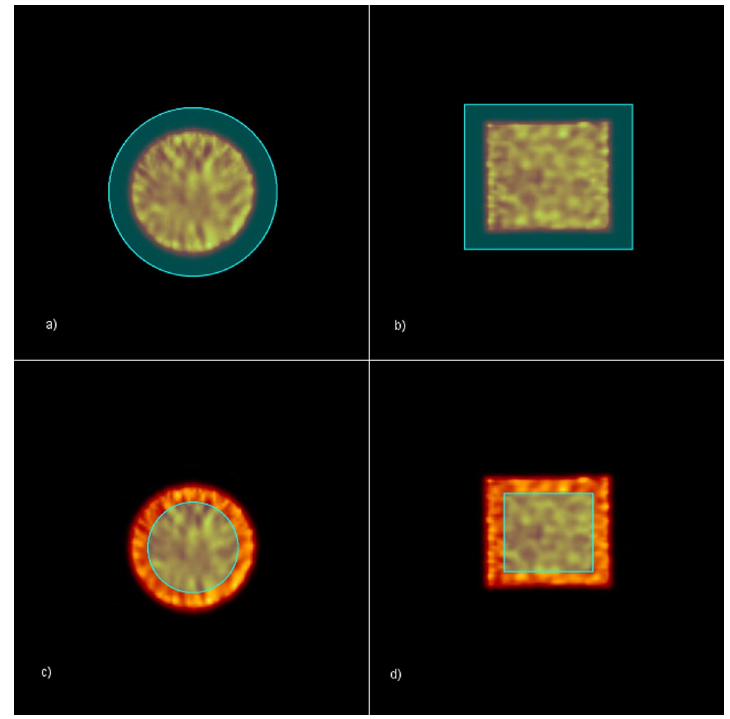
Fig. 5 Volume of interest. SPECT reconstructed transverse a and sagittal b slices of the Jaszczak phantom togheter with type 1 VOI. SPECT reconstructed transverse c and sagittal d slices of the Jaszczak phantom togheter with type 2 VOI